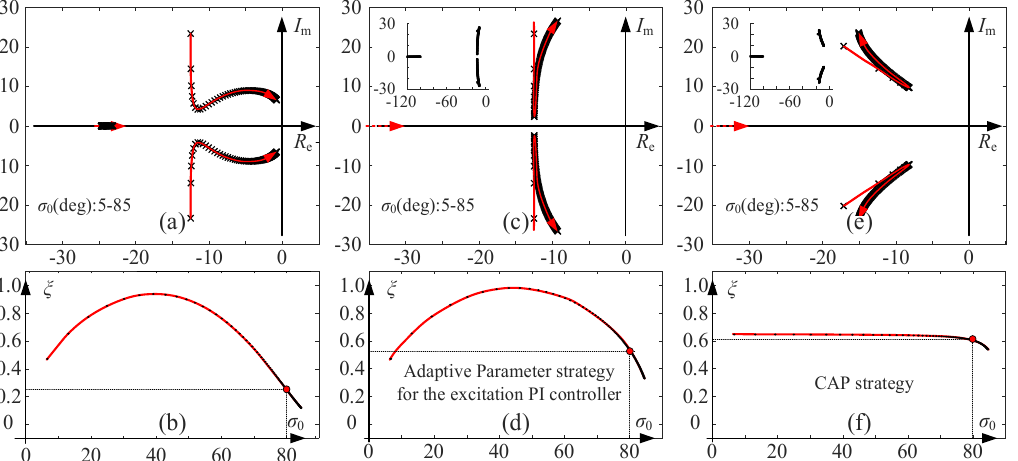
Figure 5. Comparison of the root locus and damping ratio for different strategies: ( a , b ) Root locus and damping ratio under the conventional VSG strategy; ( c , d ) Root locus and damping ratio under parameter adapting strategy for excitation controller; ( e , f ) Root locus and damping ratio under CAP